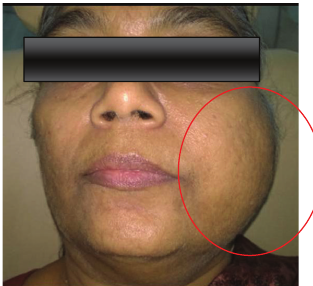
Table 3: Immunoglobulin